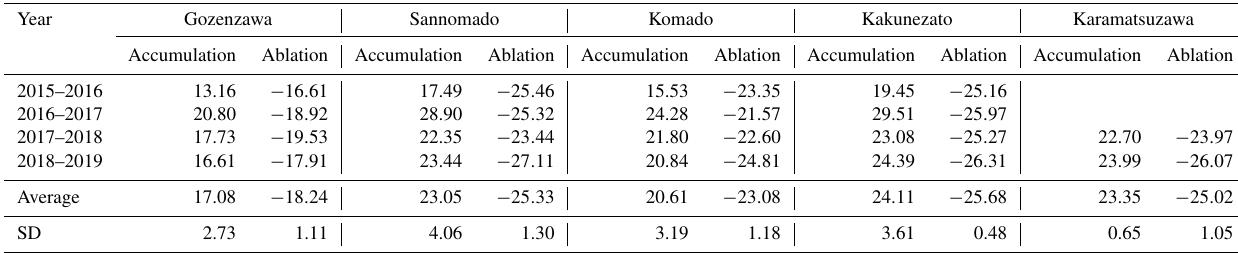
Figure 8. Annual altitude changes of each glacier and year. (a) Gozenzawa. (b) Sannomado (lower) and Komado (upper). (c) Kakunezato. (d) Karamatsuzawa. Table 4. Accumulation and ablation depth (m) of the